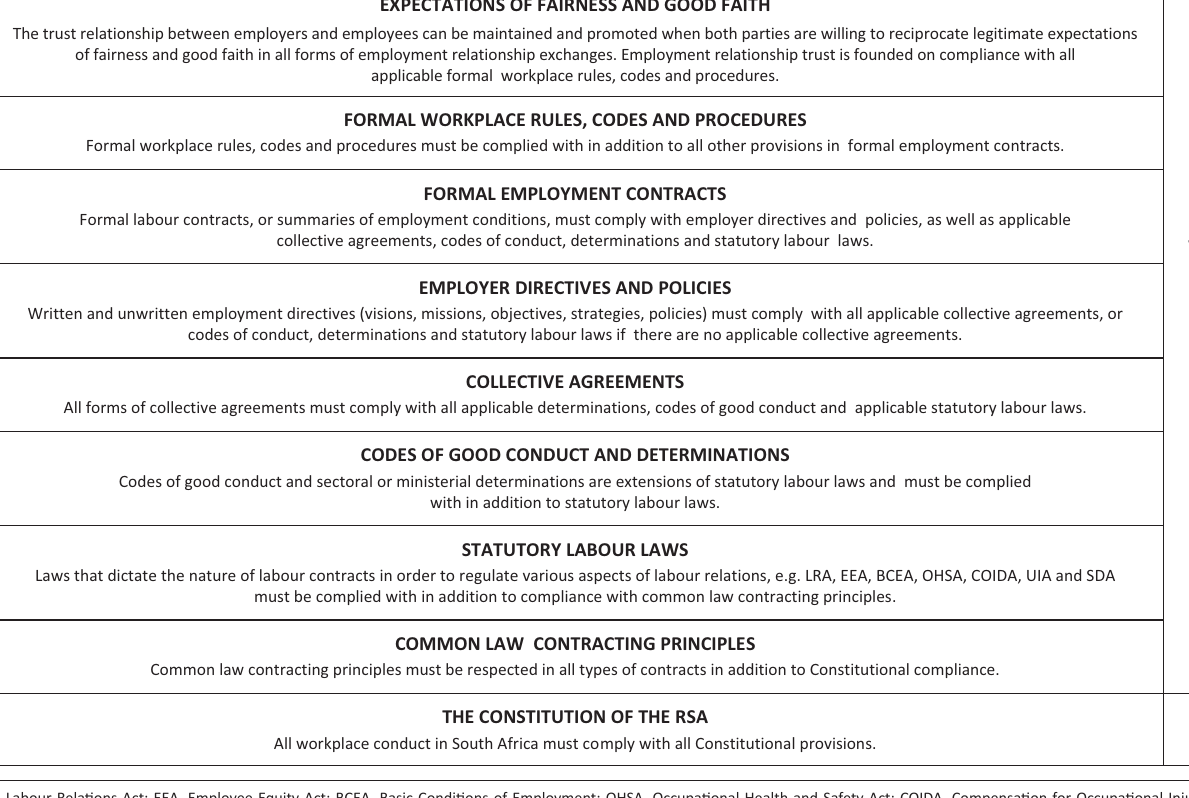
Figure 1: Labour relationship compliance